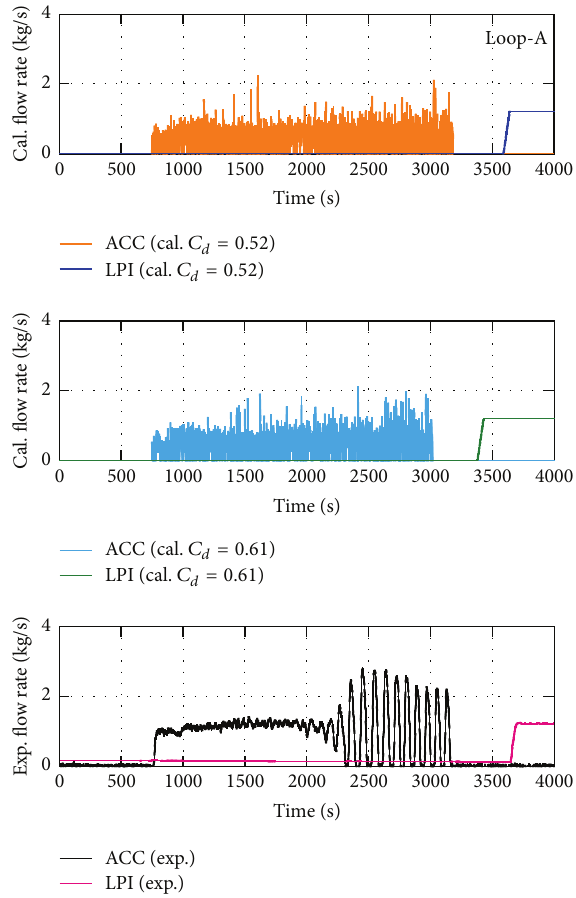
Figure 8: LSTF and RELAP5 results for flow rates of ACC and LPI systems in loop-A in case of release of dissolved